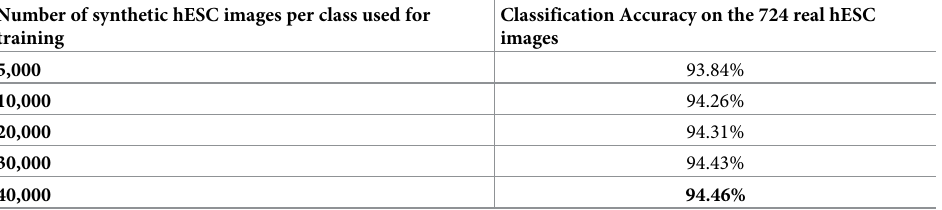
Table 14. Comparison of using different data compositions of synthetic images for training the classifier and then testing it on the 724 real images. Number of synthetic hESC images per class used for